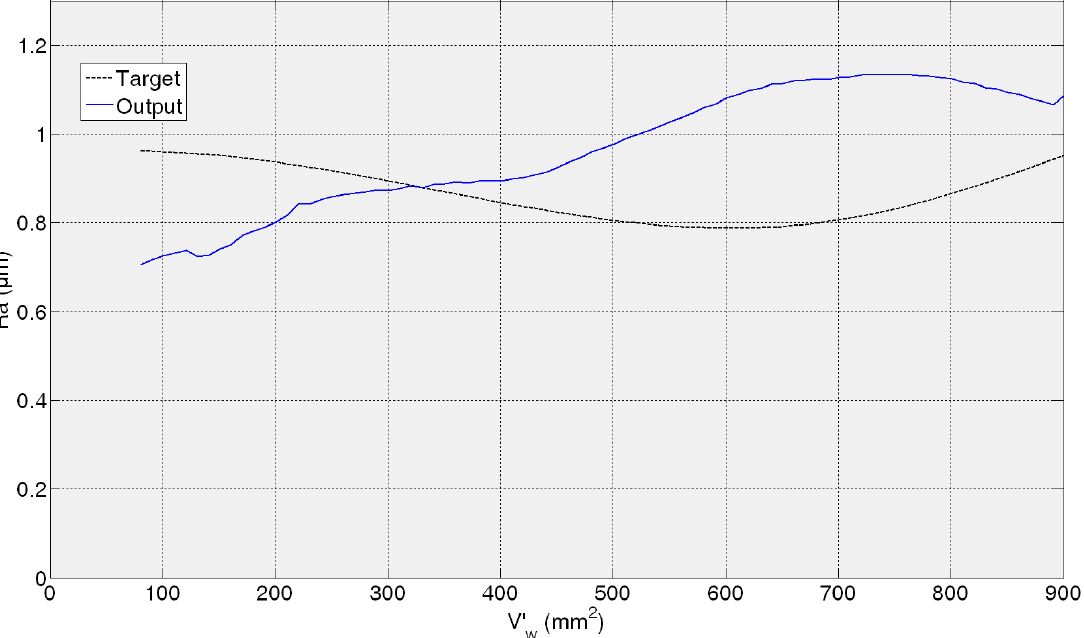
= 100 and Q' = 2.5 grinding s